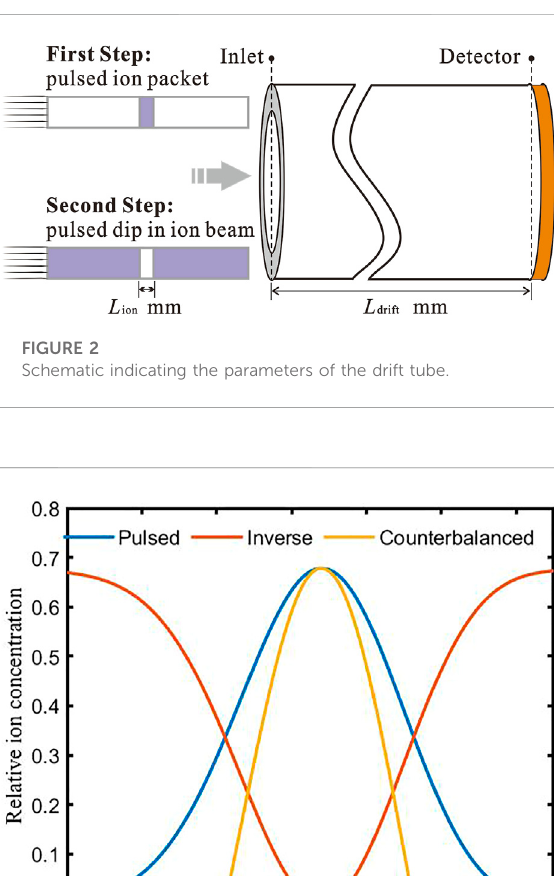
Figure 3. The blue and the red curve are the pulsed and the inverse spectra generated in the fi rst and second steps. The yellow curve is the counteracted spectrum obtained using the inverse